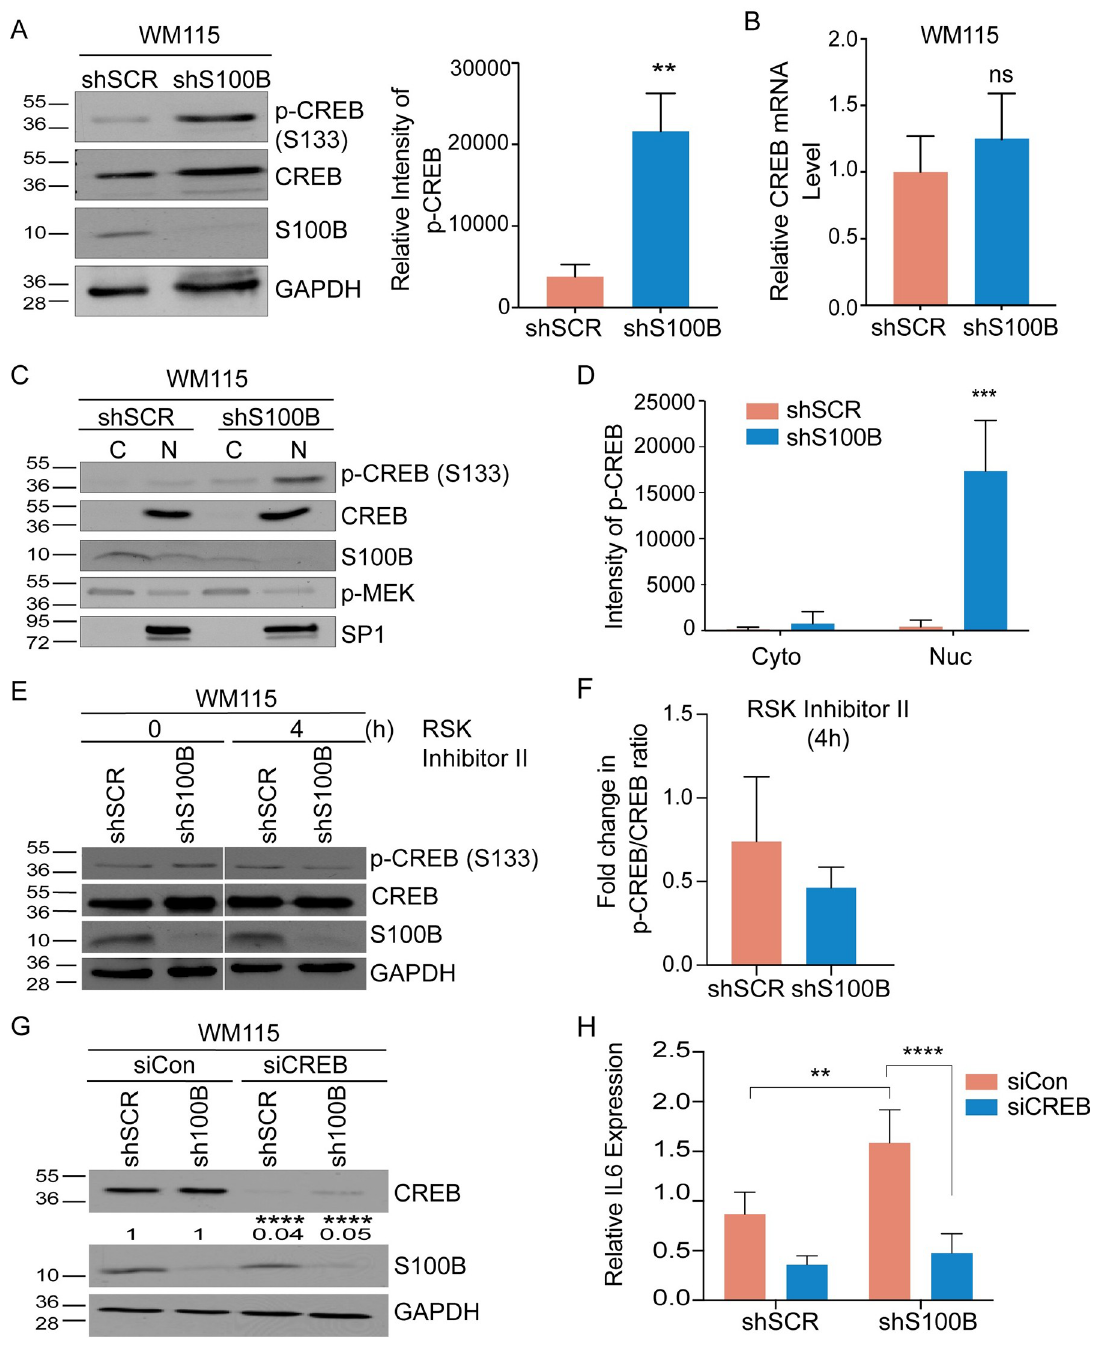
Fig 6. S100B suppresses phosphorylation and nuclear localization of CREB. (A) Immunoblot analysis of p-CREB (Ser133), in the shSCR and shS100B WM115 cells shows an increase in p-CREB (Ser133) upon S100B depletion without a significant increase in total CREB protein (n = 3; mean ± SD; �� , P < 0.005) or (B) mRNA levels in the shSCR and shS100B WM115 cells (n = 4, mean ± SD; P = NS; non-significant). (C) Immunoblot analysis of nuclear (N) and cytoplasmic (C) fractions of shSCR and shS100B WM115 cells shows that nuclear located p-CREB (Ser133) is restored upon S100B depletion, with little if any CREB observed in the cytoplasm. Also shown are S100B levels, MEK (cytoplasmic marker), and SP1 (nuclear marker). (D) The average values of p-CREB intensity were plotted using image J (n = 3; mean ± SD; ��� , P < 0.005). (E) Immunoblot analysis of the p-CREB (S133), total CREB, and S100B in shSCR and shS100B WM115 cells following 0 and 4 hours of RSK Inhibitor, BI-D1870 treatment (10 μ M). (F) The fold change of p-CREB/total CREB ratio following 4 hours of RSK inhibitor, BI-D1870, were plotted using image J. (G) Transient knockdown of CREB in the shSCR and shS100B WM115 cells with either control or two different CREB siRNAs (n = 3; mean ± SD; ���� , P < 0.0001. (H) qRT-PCR of IL6 mRNA in shSCR and shS100B WM115 cells transfected with either control or CREB siRNA shows loss of IL6 transcription with CREB knocked down (n = 3; mean ± SD; �� , P < 0.005; ���� , P < 0.0001).